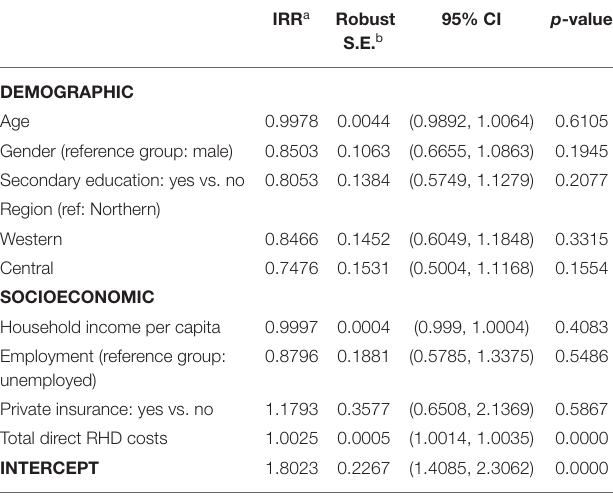
TABLE 4 | Effect of demographic and socioeconomic factors on utilization of coping